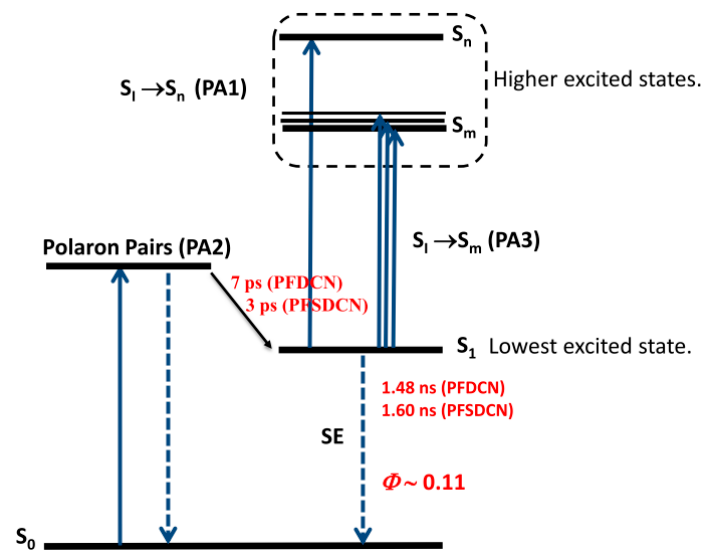
Figure 6. Energy diagrams for PF(S)DCN in chlorobenzene solution. The photo excitation produce